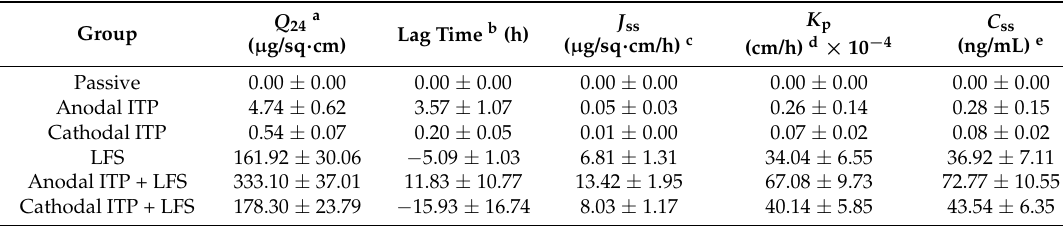
Transdermal delivery, lag time, flux, permeability coefficient, and steady-state plasma concentration of in vitro permeation of MTX though dermatomed human cadaver skin (mean ± SD, n = 4). Group